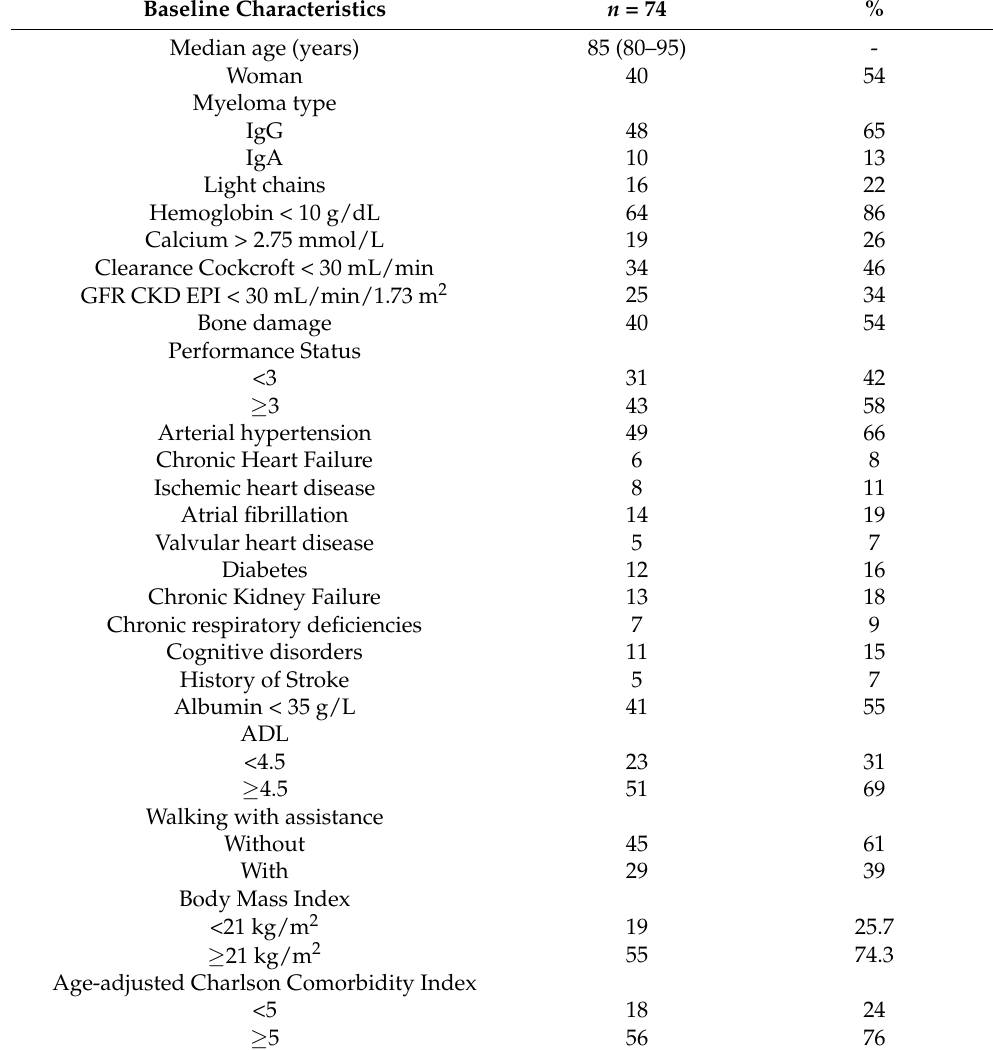
Table 1. Patients’ characteristics and geriatric assessment of the study